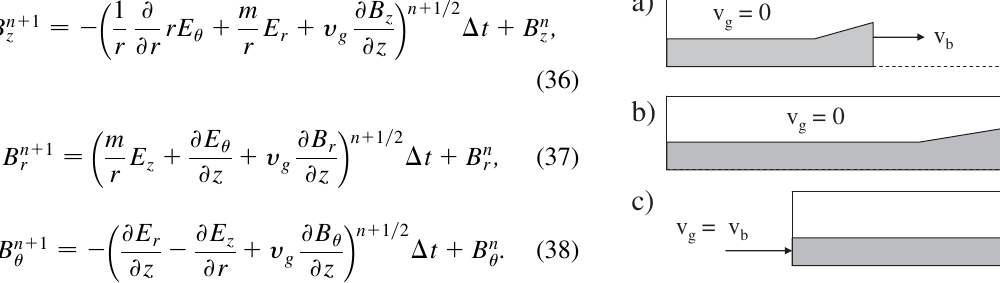
is injected into the b (cid:6) 0 ). (b) The box remains sta- g (cid:6) v g b